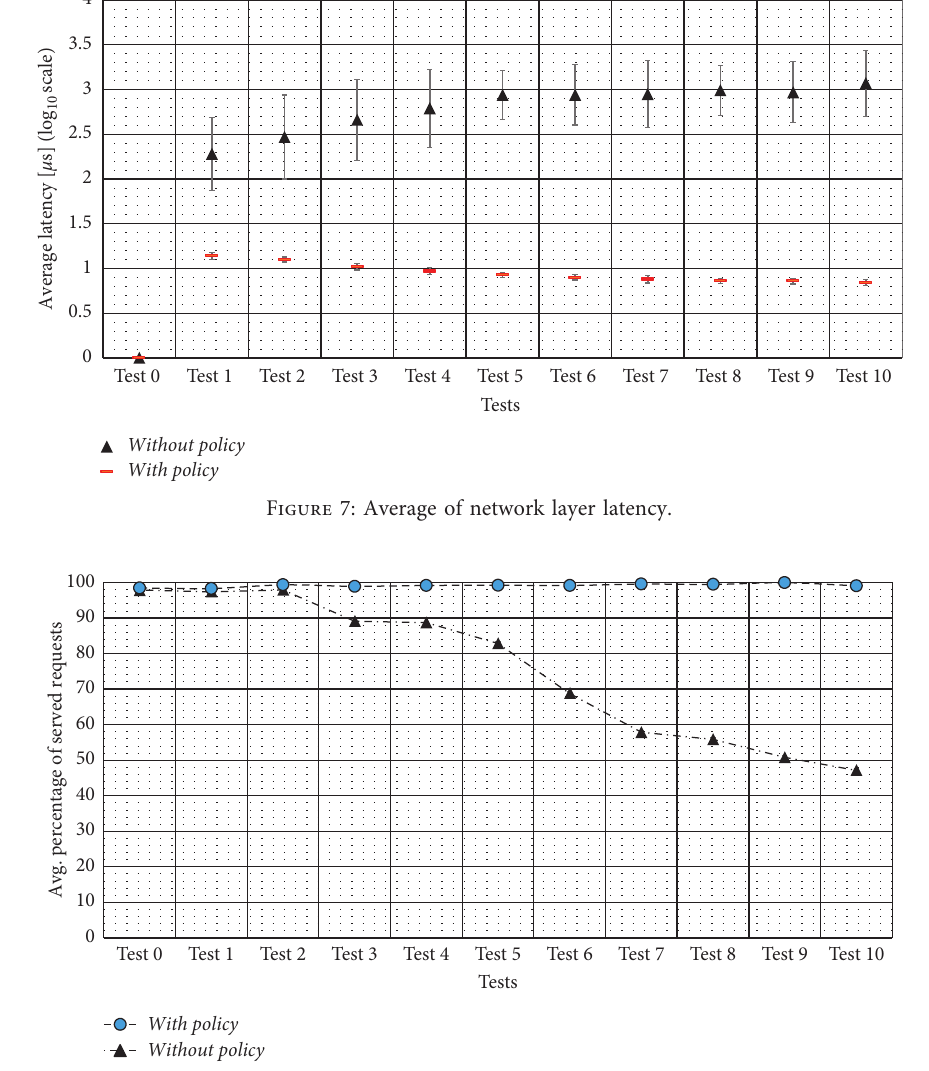
Figure 8: Average percentage of served echo